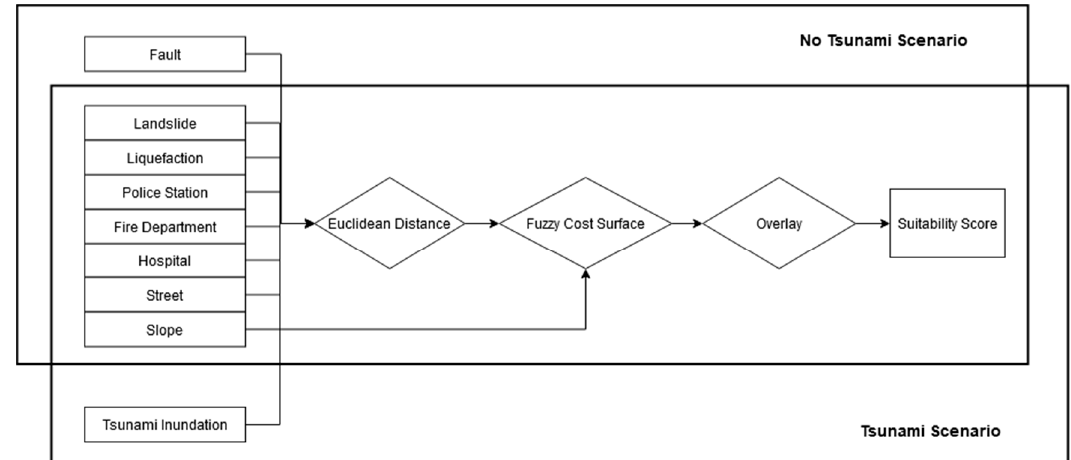
Figure 2. Suitability Model.